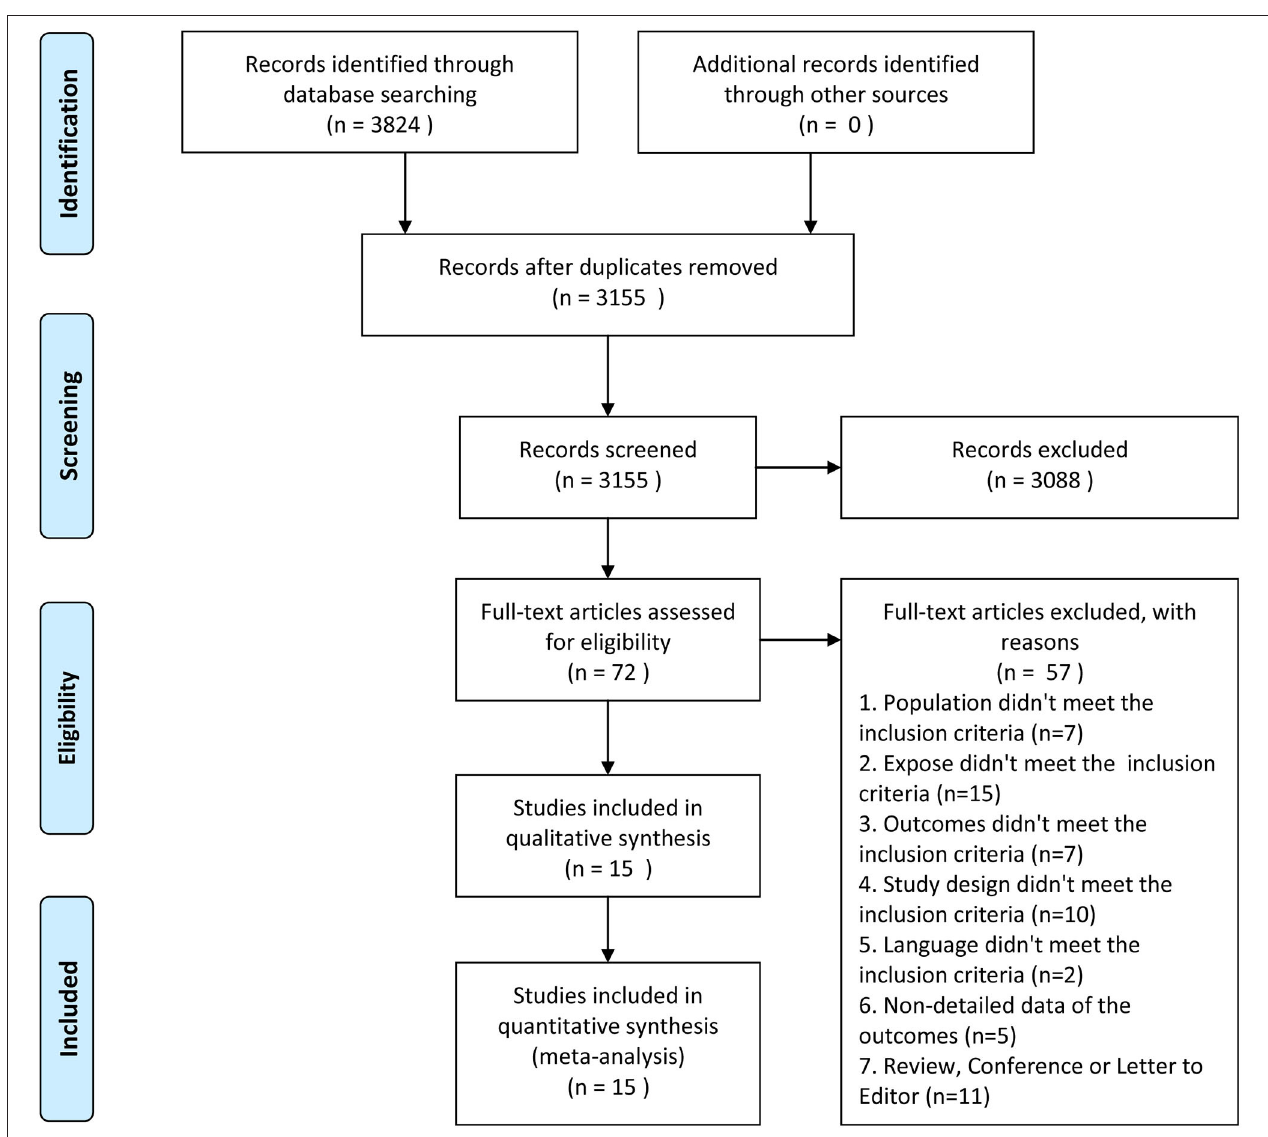
FIGURE 1 | Flow diagram of selection